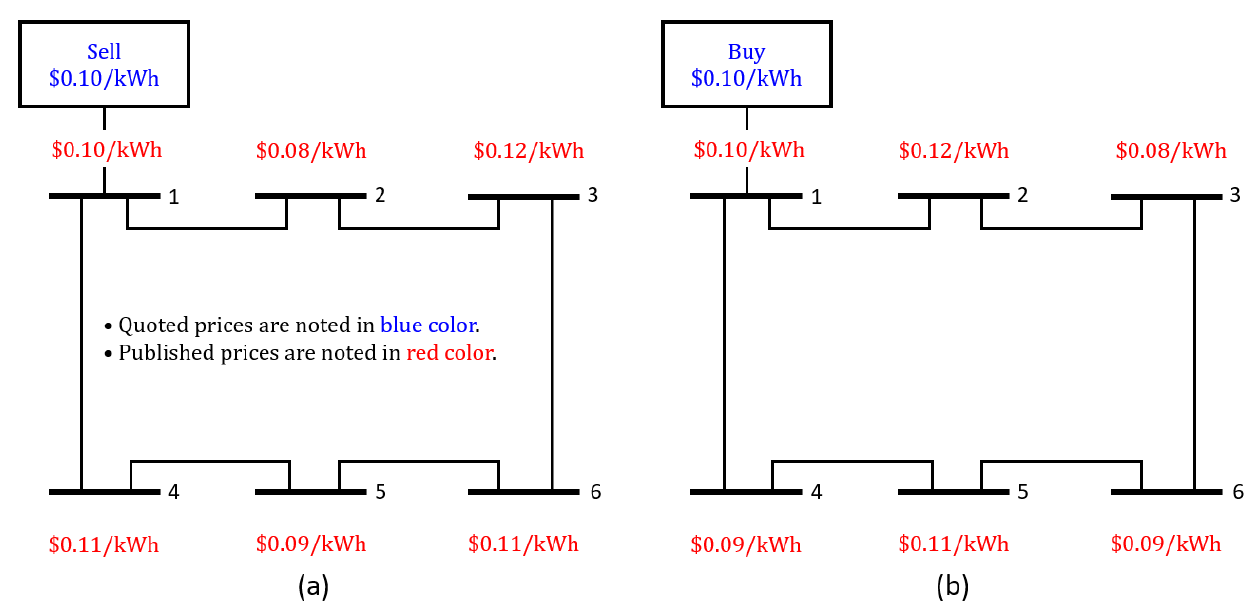
Figure 1. Examples of adjusted prices published to other nodes considering the network impacts: ( a ) offers ( b ) bids.